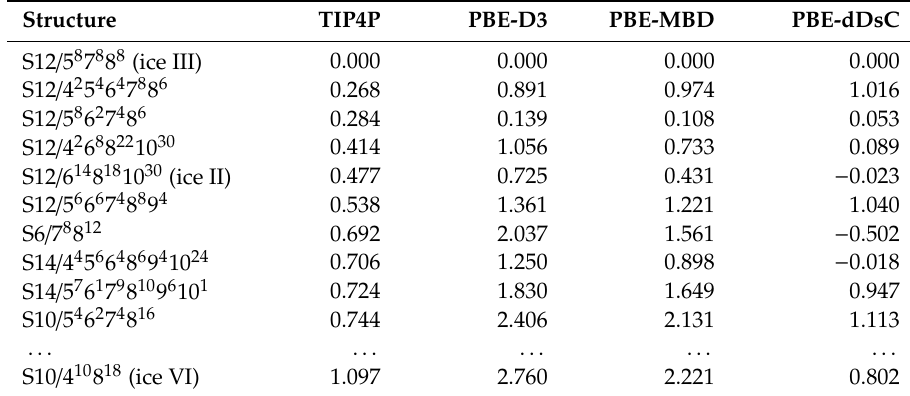
Table 2. Comparison between TIP4P- and DFT-Predicted Ten Lowest-Relative-Enthalpy-per-Molecule Structures at 4 kbar; also shown is that for ice VI, given the 4 kbar pressure.